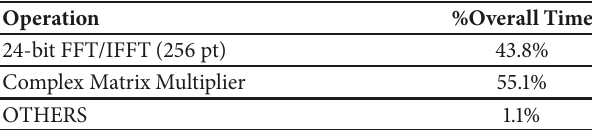
Table 2: Profiling results of detailed